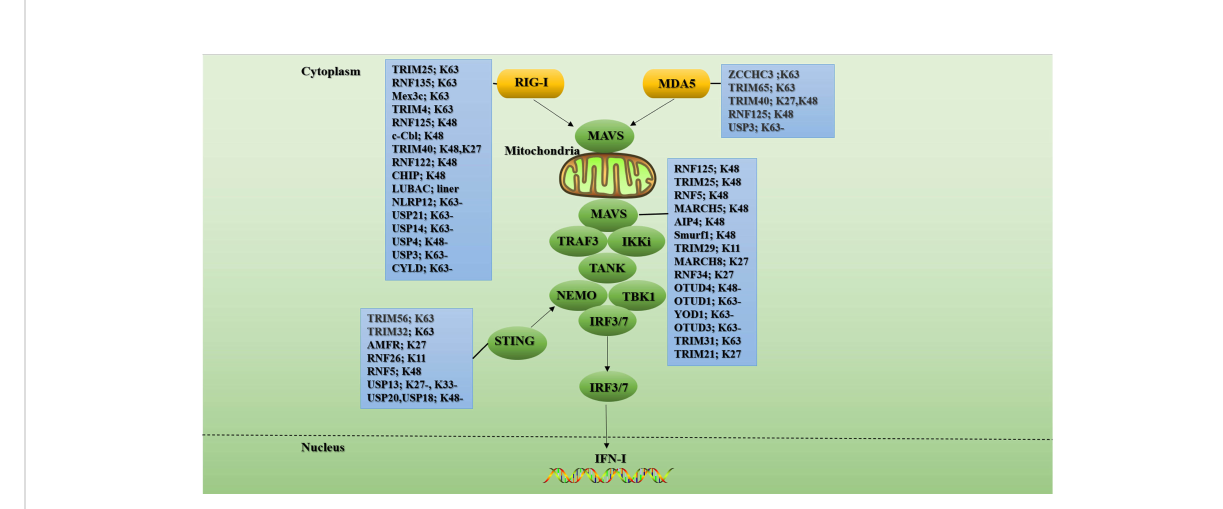
FIGURE 3 Ubiquitination and de-ubiquitination in the RLR signal. RIG-I/MDA5 undergoes signi fi cant conformational changes upon ligand binding. Then they bind to the adaptor protein MAVS on the outer membrane of mitochondrial through CARD-CARD homotypic interactions. These further triggers MAVS to recruit other signaling partners including TRAFs, TANK, and NEMO to activate IKK ϵ and TBK1. Ultimately, the transcription factors IRF3 and IRF7 are phosphorylated by activated TBK1 and then translocated into the nucleus to initiate antiviral gene transcription. K63- linked polyubiquitination of signaling molecules such as RIG-I, MDA5, MAVs, and STING is critical for RLR signaling. Conversely, K48-linked ubiquitination and subsequent proteasomal degradation play important roles in fi ne-tuning RLR antiviral innate immunity. In the blue boxes are the E3s or the DUBs involved in the regulation of this signaling protein. “ - ” means removing. The fi gure is referenced from Figure 2 of Ubiquitin in the activation and attenuation of innate antiviral immunity